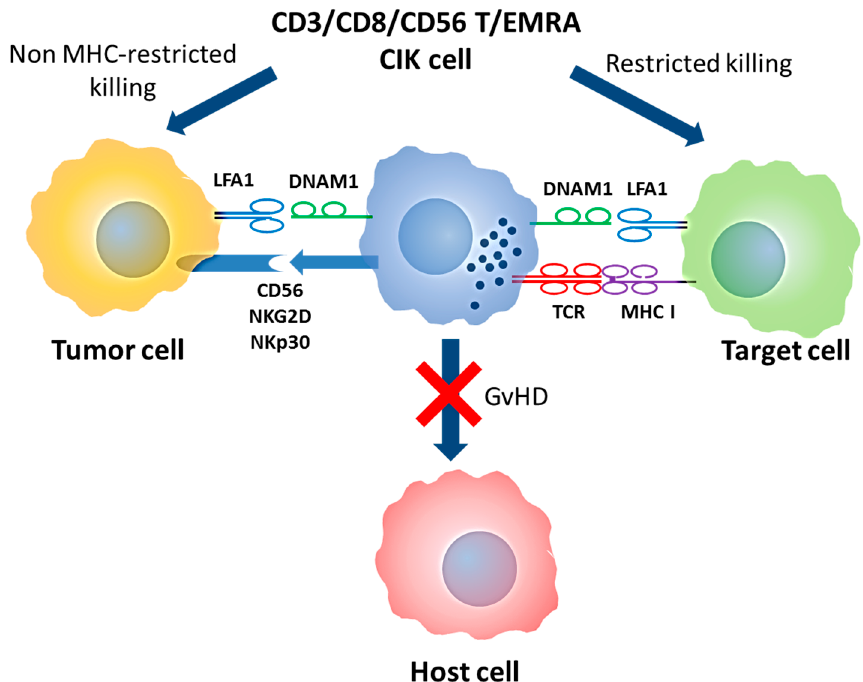
Figure 1. Double T/NK specificity of CIK cells and mechanism of action. CIK cells are T-EMRA lymphocytes that maintain the original TCR specificity and acquire NK-like cytotoxicity. In both cases, DNAM1 and LFA1 are required for target binding while NK-like cytotoxicity is mediated by CD56, NKp30 and NKG2D molecules. Abbreviation: MHC (Major Histocompatibility Complex); GVHD (Graft versus Host Disease); T/NK (T Natural Killer); CIK (Cytokine Induced Killer); T-EMRA (Effector memory T); TCR (T cell receptor); NK (Natural Killer); DNAM1 (DNAX Accessory Molecule-1); LFA1 (Lymphocyte function-associated antigen 1)